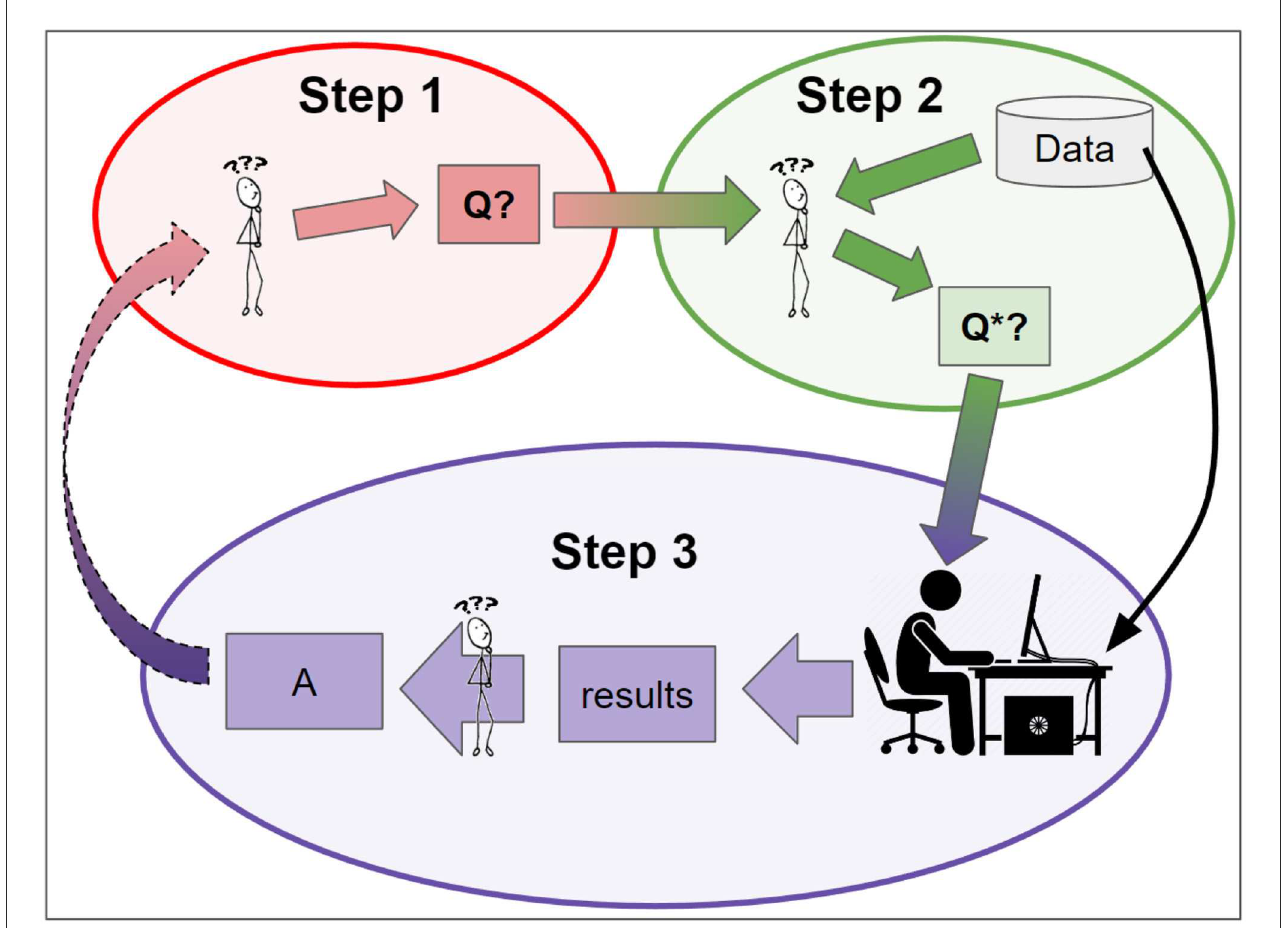
FIGURE1 A conceptual model of real world data analysis and its role within the larger process of inquiry. Step 1: the investigators identify a big picture question: Q. Step 2: they refine Q into a mathematically precise question, Q*, that can be directly addressed with available data and methods. Step 3: a formal data analysis process is applied to the data, and results are interpreted to produce an answer to Q* and improve understanding of Q. This answer may lead to the development or refinement of new big picture questions, thereby spurring further